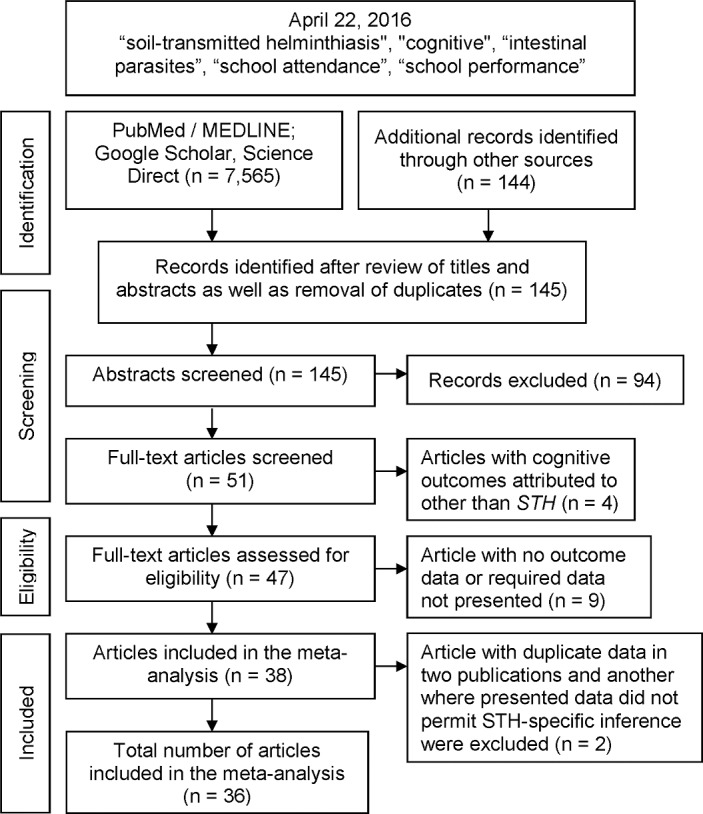
Summary flowchart of literature search.